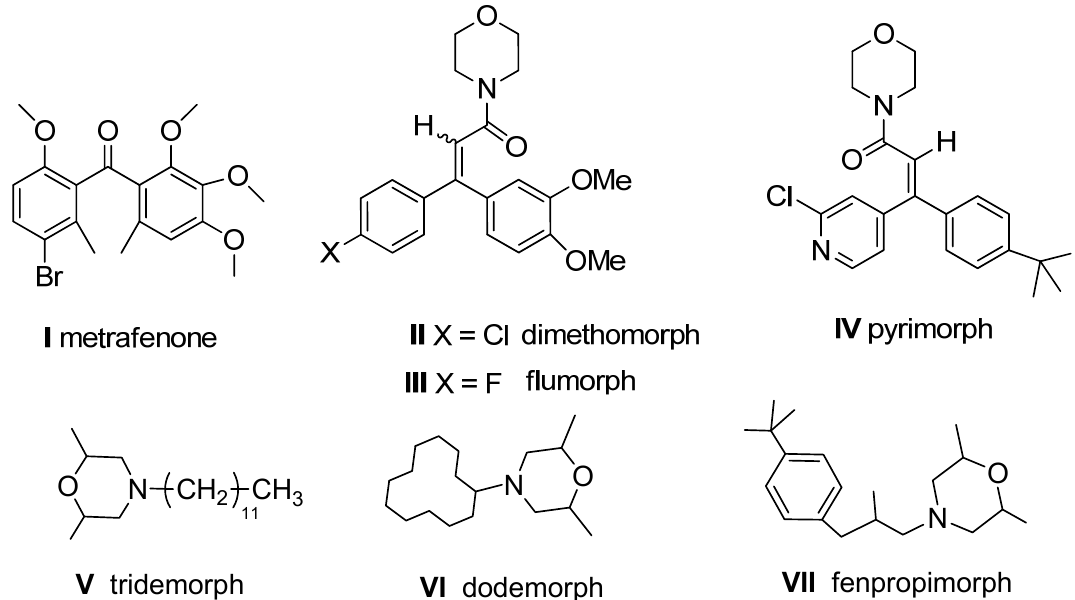
Figure 1. The chemical structures of several commercial